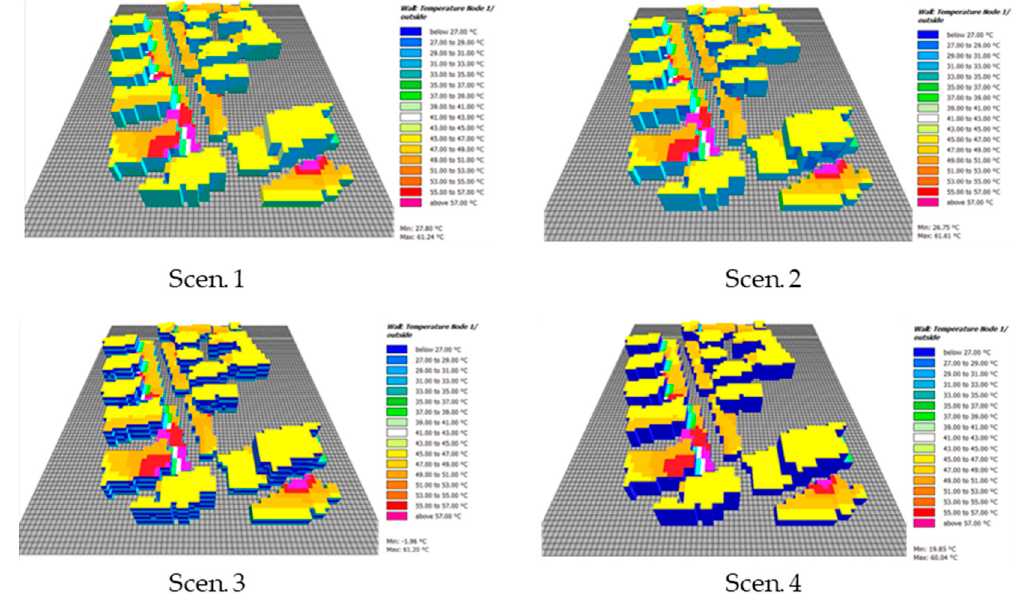
Figure 11. The outside wall surface temperature of the four scenarios at 4 p.m.